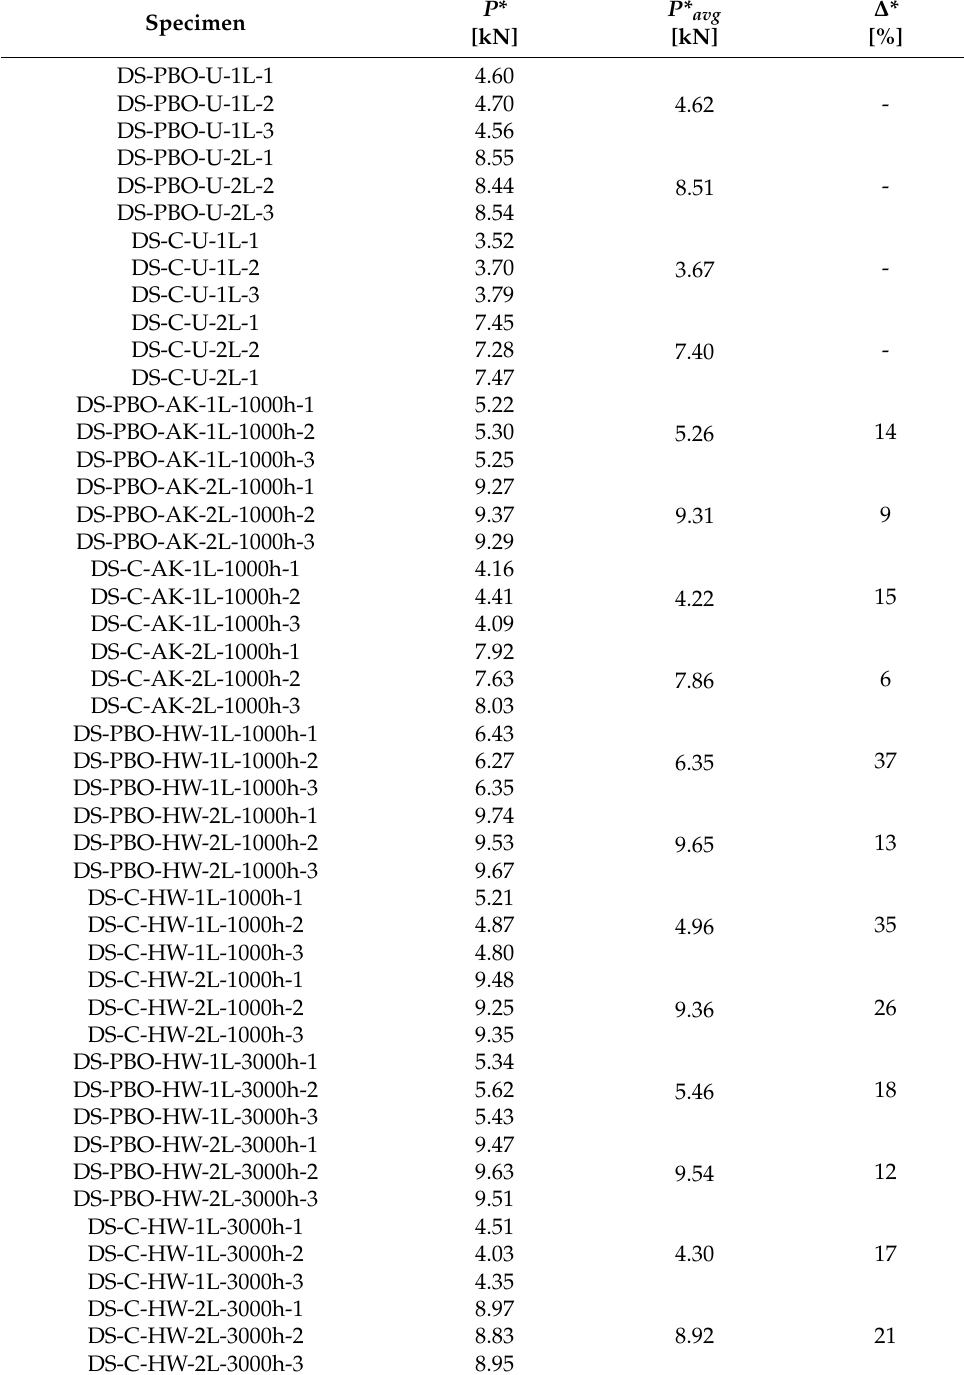
Table 3. Experimental